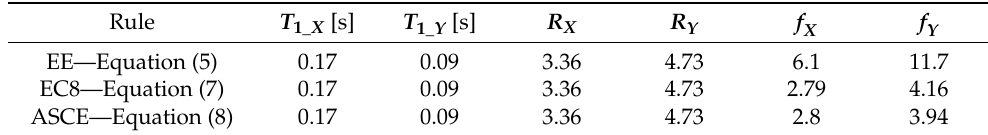
Table 5. Amplification factors f X and f Y obtained from Equations (6) and